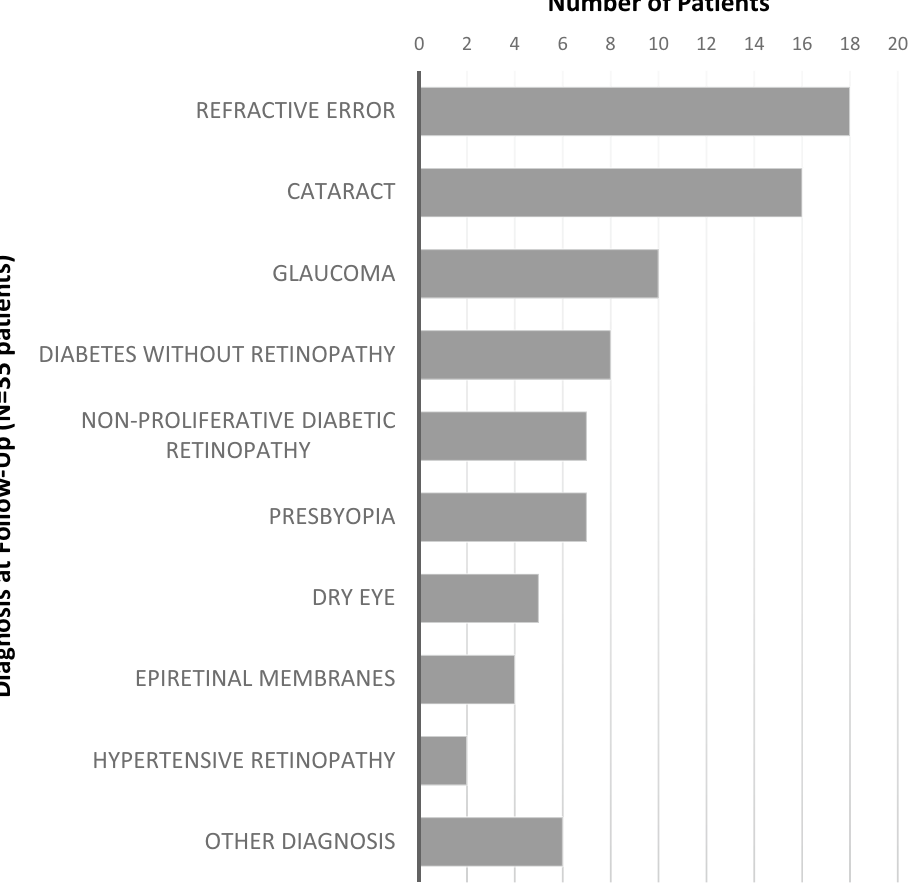
Figure 1. Summary of patient diagnoses at follow-up. The diagnosis or diagnoses of each patient at the follow-up appointment are listed. The other diagnosis category includes diagnoses that were only seen in one patient at follow-up. These diagnoses include central retinal vein occlusion, chorioretinal scar, ocular foreign body, macular lesion, posterior capsular opacification, and